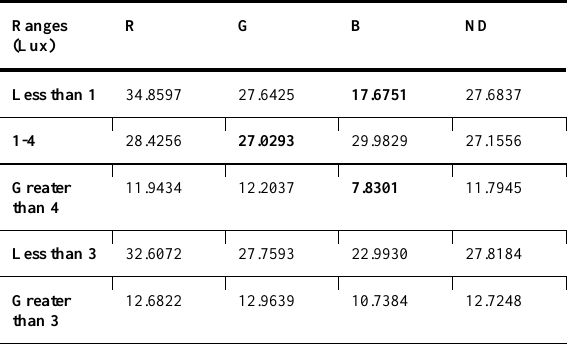
Table 6. Statistical comparison of average percent error per